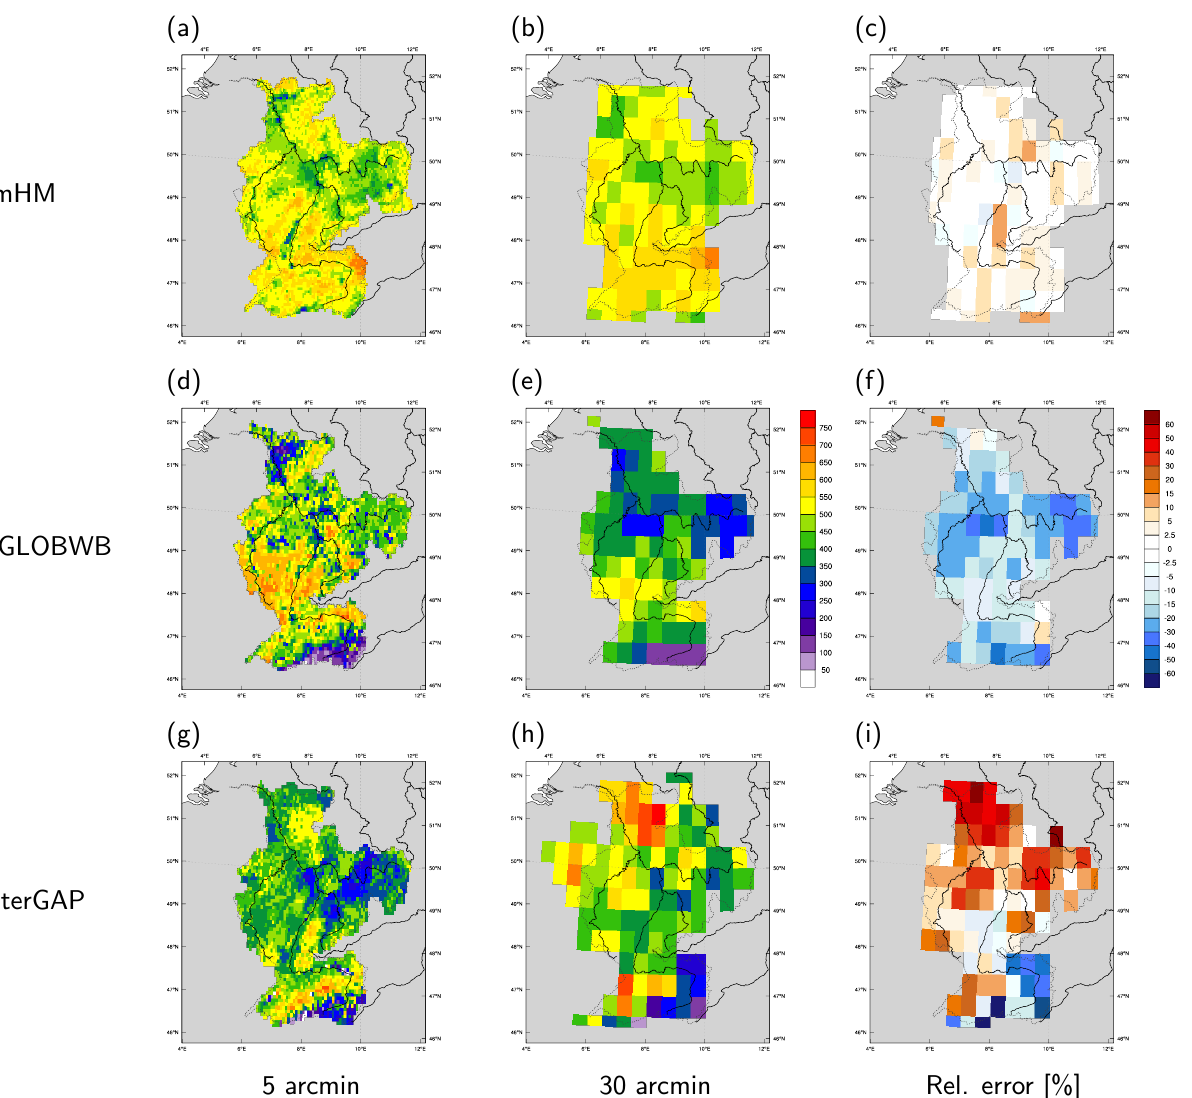
Figure 7. Multiscale simulation of annual ET for the Rhine River in 2003 with mHM, PCR-GLOBWB, and WaterGAP (versions 3 and 2) at spatial resolutions (cid:96) 1 of 5 and 30arcmin, respectively. The relative errors in percentage of the coarse field estimates with respect to the finer ones (aggregated to the coarser level) for mHM, PCR-GLOBWB, and WaterGAP are shown in panels (c) , (f) , and (i) ,